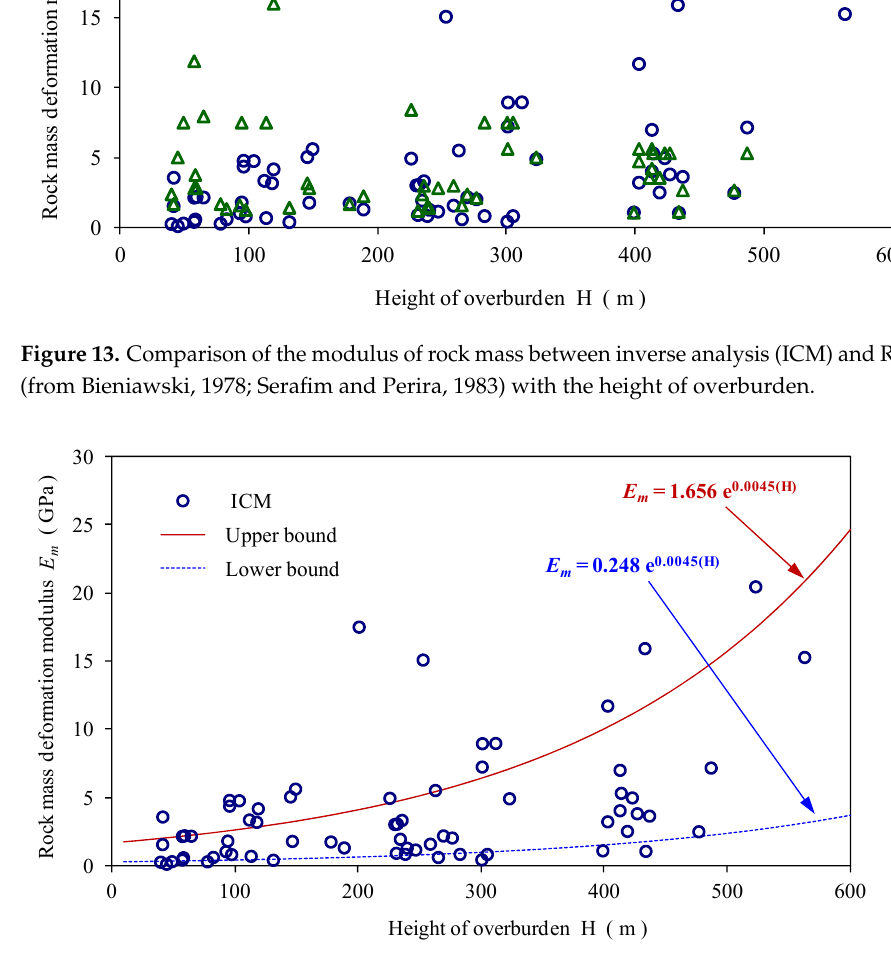
Figure 14. Correlation between modulus of the rock mass predicted by the inverse analysis (ICM) and height of overburden.